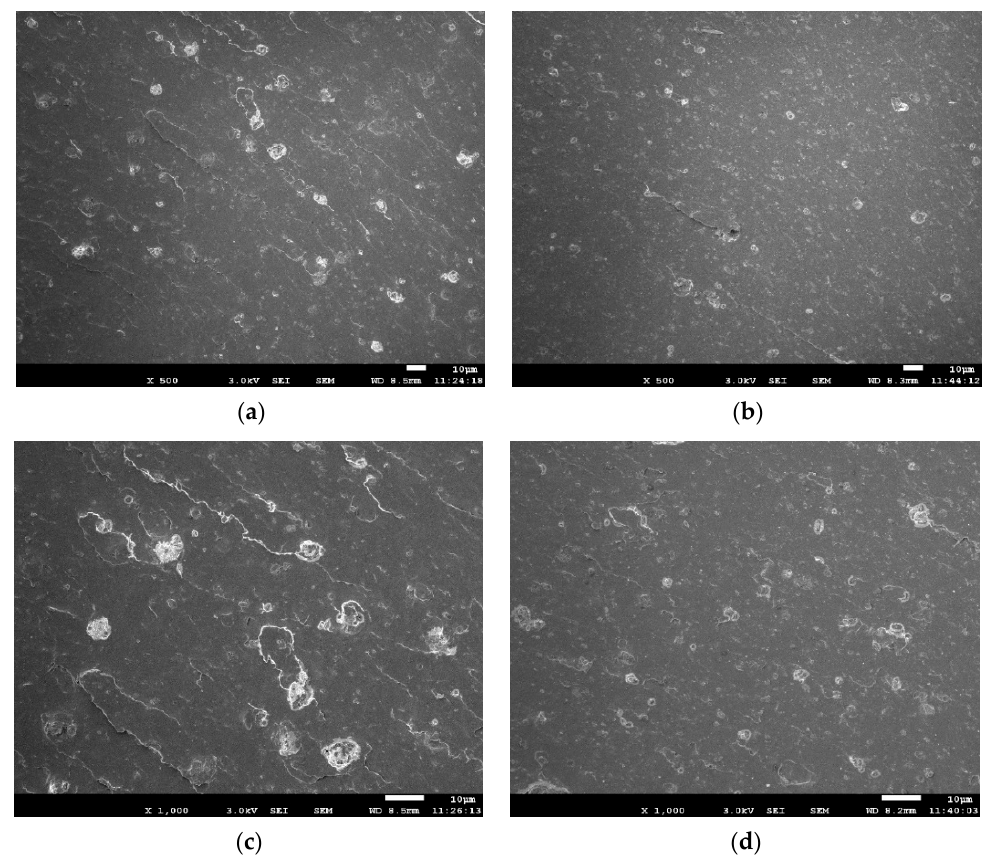
Figure 7. Scanning electron micrographs of PEG0 and PEG4 composites with two magnifications. ( a ) PEG0 with ×500 magnification; ( b ) PEG4 with ×500 magnification; ( c ) PEG0 with ×1000 magnification; ( d ) PEG4 with ×1000 magnification.